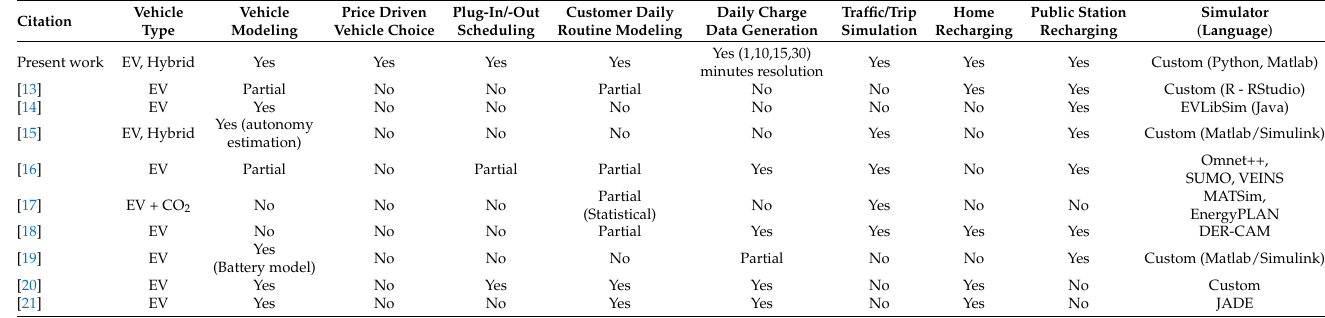
Table 1. Overview of the different simulation approaches presented in Section